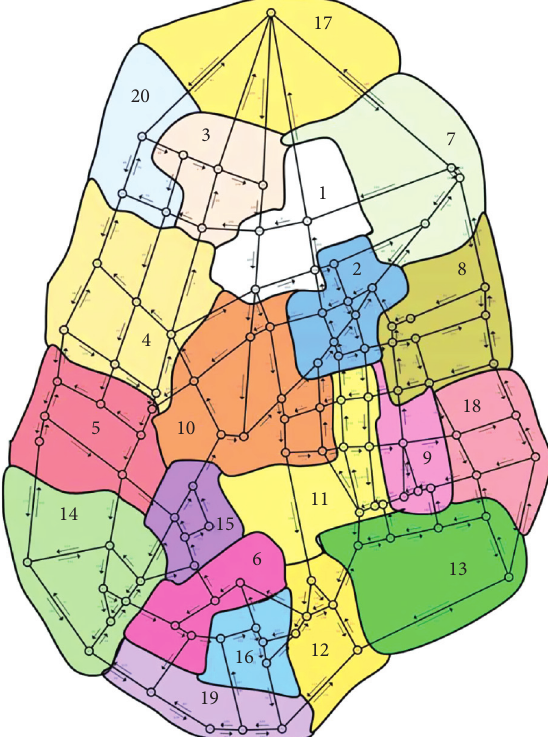
Figure 10: The Ciudad Real network (adapted from Castillo et al. [1]). Table 9: Sets of routes that appear with the application of the proposed algorithm for the Ciudad Real network case. Threshold flow, F thres